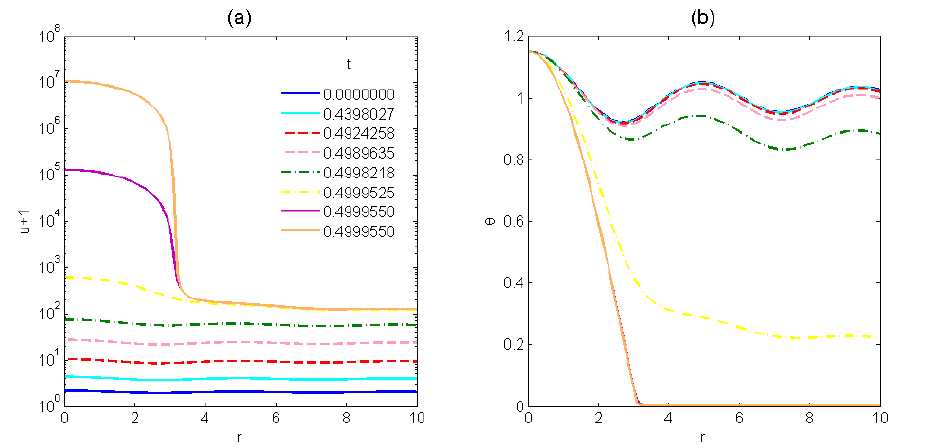
Figure 3. Zoom in the region near the origin of the graphs in Figure